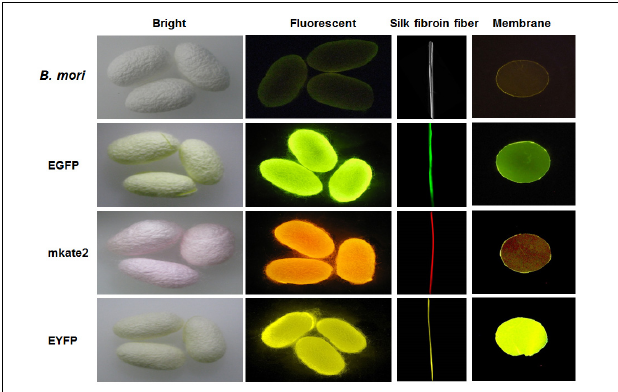
FIGURE 3 | Fluorescent cocoons, silk fibroin fibers, and membranes. The fluorescent cocoons produced by transgenic silkworms had various fluorescent proteins, including EGFP, mKate2, and EYFP. Reproduced from Kim et al. (2015) with permission from ELSEVIER.